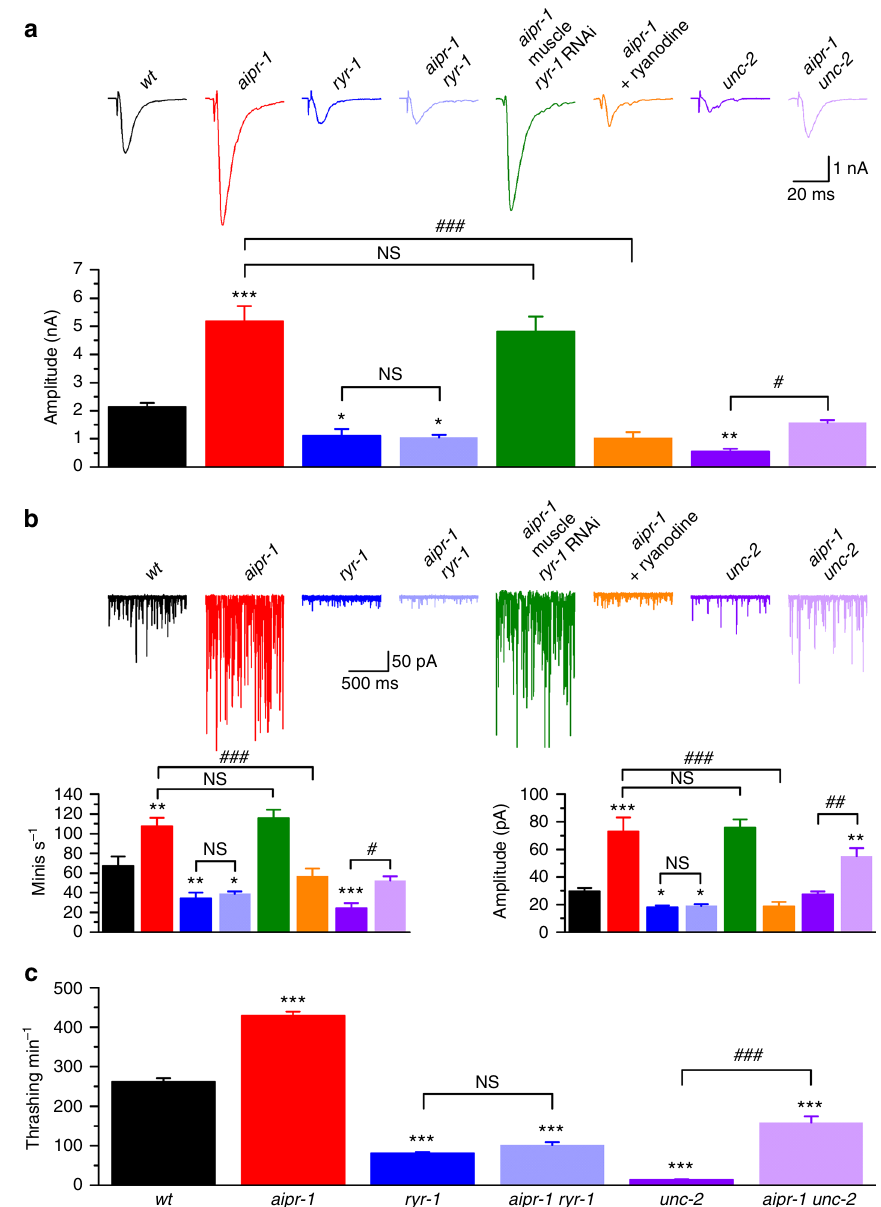
Fig. 4 Mutation of RYR-1 but not UNC-2 occluded synaptic and behavioral phenotypes of aipr-1(zw86) . a , b Comparison of evoked currents a and spontaneous miniature currents (minis) b among wild type ( wt ) ( n = 8), aipr-1(86) ( n = 7), ryr-1(e540) ( n = 7), aipr-1(zw86) ryr-1(e540) ( n = 7), aipr-1 (zw86) with muscle ryr-1 RNAi ( n = 7), aipr-1(zw86) treated with ryanodine (100 µ M) ( n = 8), unc-2(e55) ( n = 9), and aipr-1(zw86) unc-2(e55) ( n = 7). c Comparison of thrashing rates among these groups ( n = 12 or 13). Data are shown as mean ± SEM. * p < 0.05, ** p < 0.01, *** p < 0.001 compared with wt ; # p < 0.05, ## p < 0.01, ### p < 0.001 compared between indicated groups; NS p > 0.05 (one-way ANOVA followed by Tukey ’ s post-hoc To determine the expression pattern of AIPR-1, we generated a transcriptional reporter in an extrachromosomal array by in vivo recombination. A fosmid (WRM065bd01) containing the entire operon was coinjected with a plasmid containing homologous DNA encompassing 0.5 kb upstream of the aipr-1 start codon fused to green fl uorescent protein (GFP). In transgenic worms, GFP was observed in a variety of cell types, including neurons, body muscles, amphid sheath cells, spermatheca, and the intestine (Fig. 3a). Both acetylcholine and GABA motor neurons express aipr-1 , as indicated by the co-labeling of these neurons by a red fl uorescent protein expressed under the control of cell-speci fi c promoters (Fig. 3b, c). To determine the subcellular localization